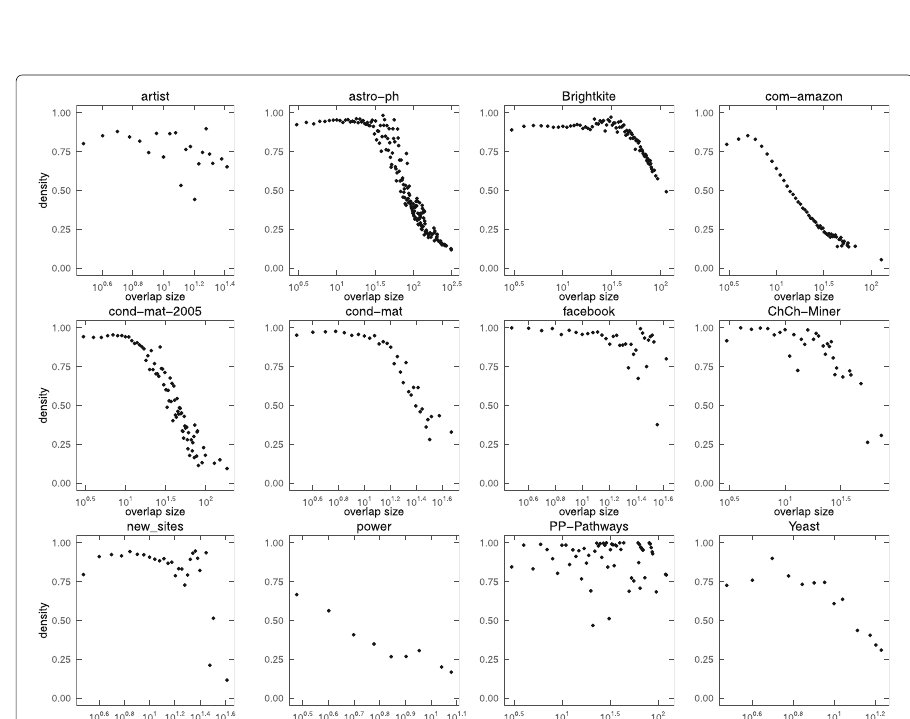
Fig. 26 Density of zone overlaps in real-world